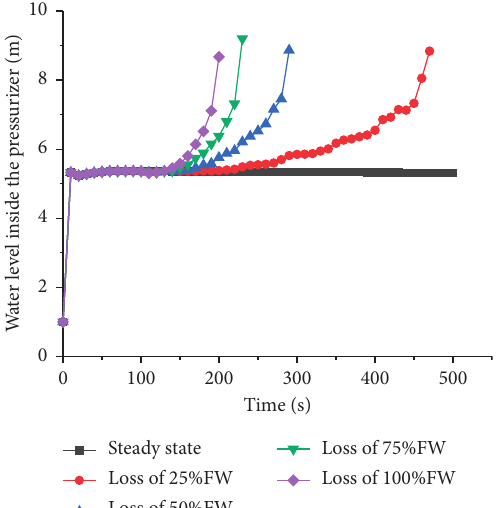
Figure 3: Water level variation inside the pressurizer for several fault severities.